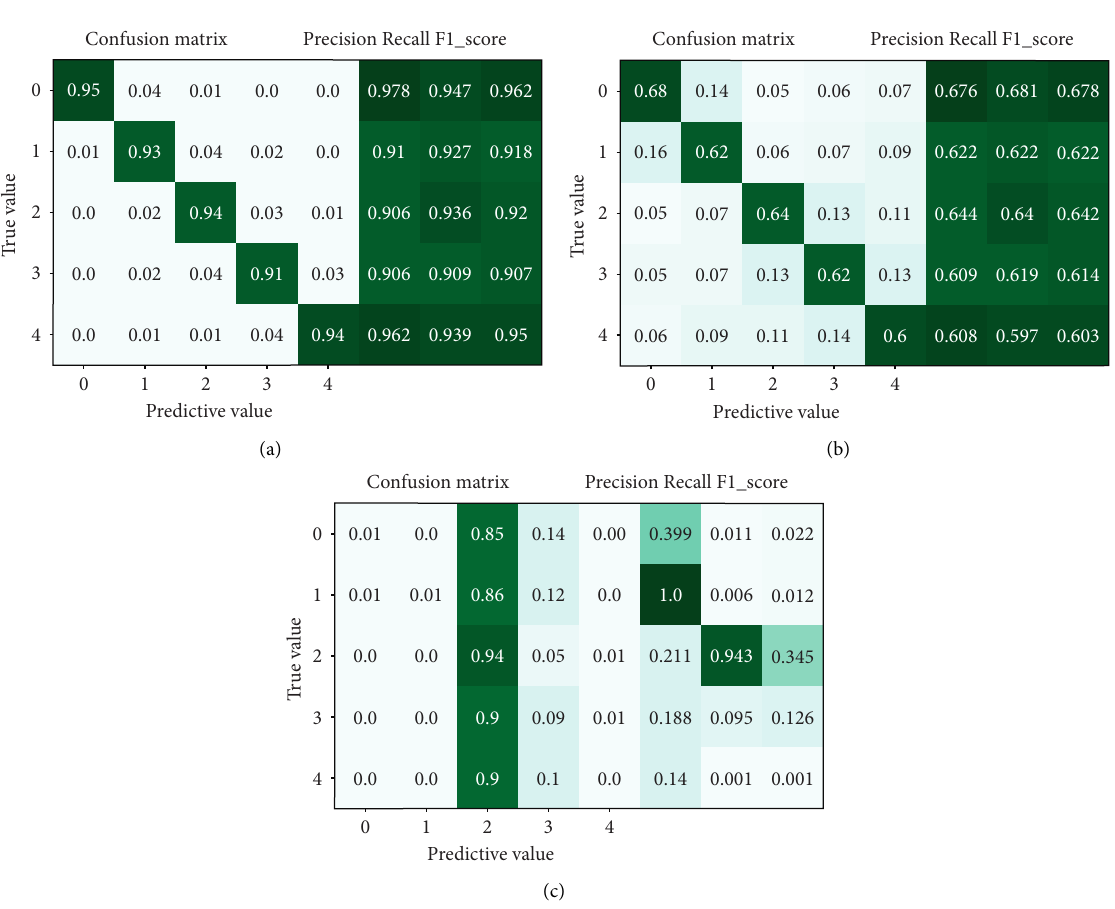
Figure 14: The result of model evaluation. (a) The result of RFs model. (b) The result of CART model. (c) The result of SVM the validation set data are inputted into the axial piston pump fault model one by one according to the category, and the model diagnosis output data obtained is shown in Figure 16. In the process of visual analysis of fault diagnosis data of axial piston pump, the position of the arrow in the radar chart represents the fault diagnosis type of the test set. It can be seen from Figure 16 that for normal state Figure 15: Workflow of RFs model testing. 16(a), single loose slipper 16(c), swash plate wear 16(d),